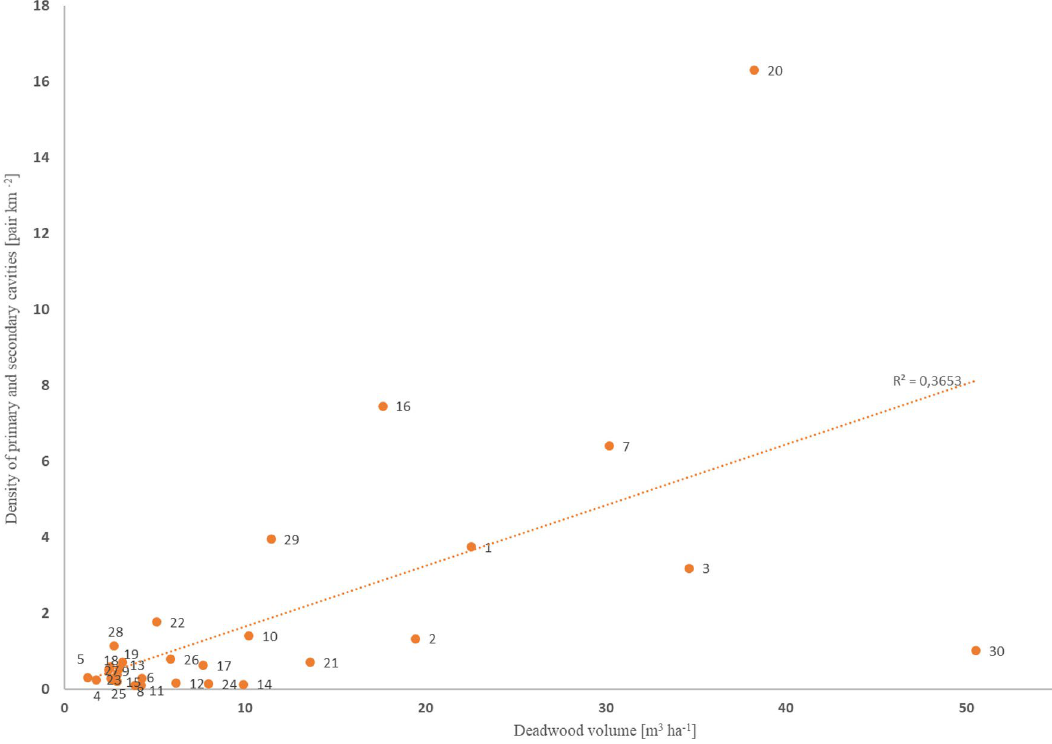
Figure 8. Relationship between the density of primary and secondary cavity nesters and deadwood volume in 30 SPAs. Analysis includes twelve bird species 2 (see Table S1 in the supplementary materials as well as the “Study area and material” section). The numbers provided next to the points in the chart represent SPA numbers according to column 1 in Table